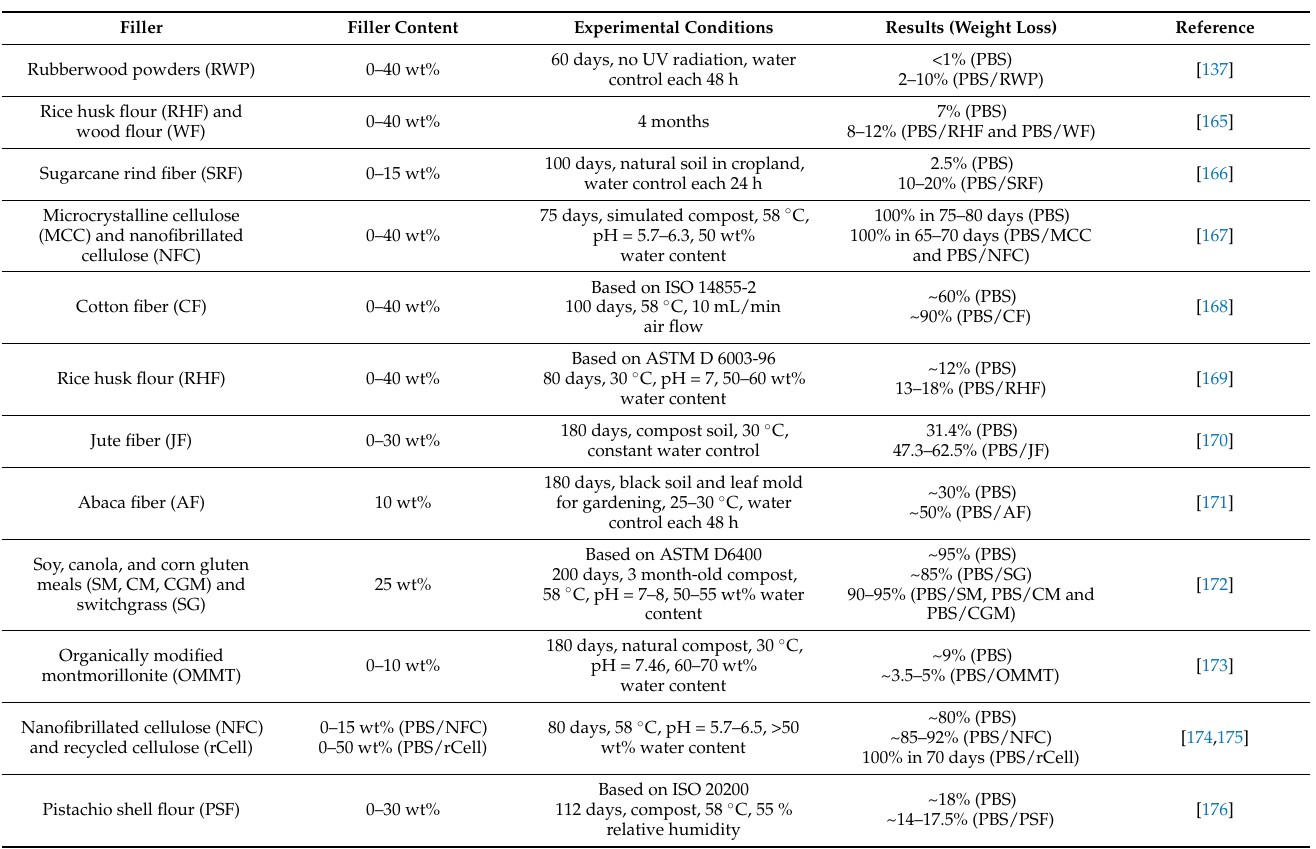
Table 2. Different biodegradation studies of PBS and PBS biocomposites carried out in environmental